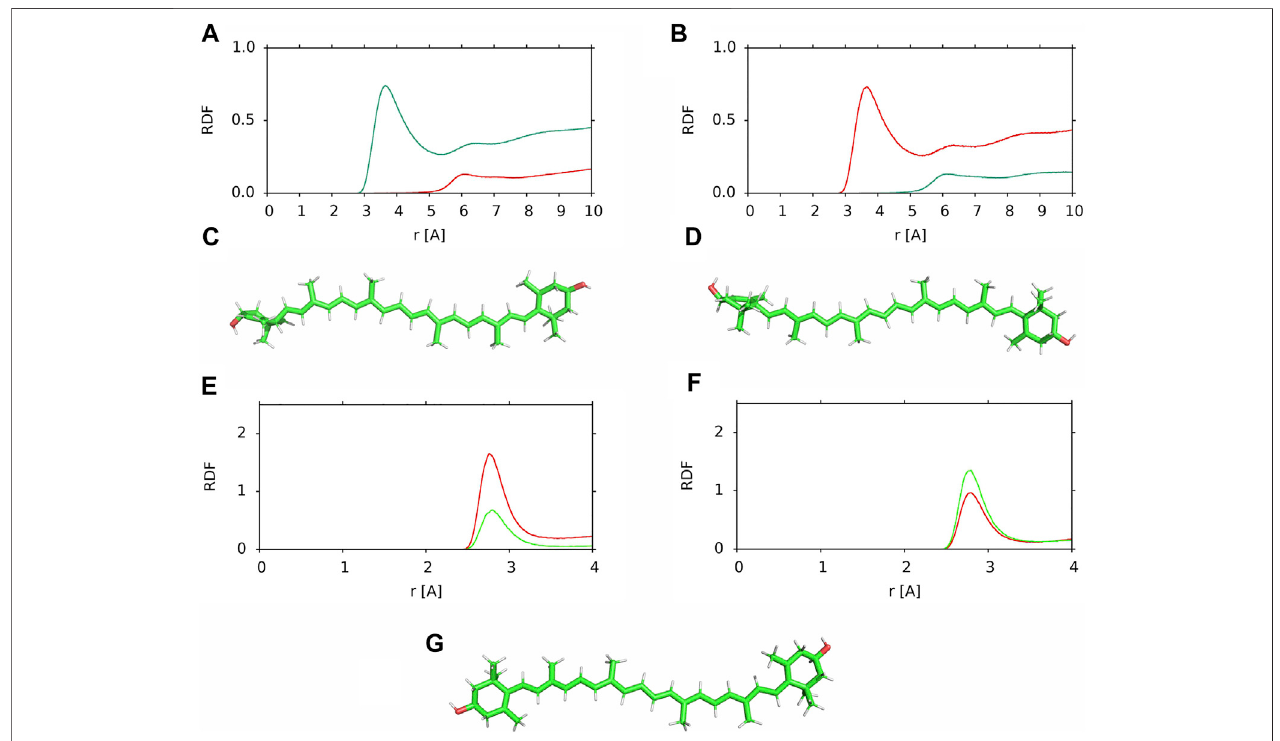
FIGURE 9 | (A,B) RDF of water molecules relative to the MET groups of the ( red ) ß -ring and ( green ) ε -ring halves of the polyene chain in the PC-LUT_H bilayer (A) lutein#6, (B) lutein#4; (C,D) positionsrelativetothe “ upper ” bilayerlea fl etofthehorizontallyorientedluteinmoleculesinthePC-LUT_Hbilayer (C) lutein#6, (D) lutein#4; (E,F) RDF of water molecules relative to the OH groups of the (E) ß -ring and (F) ε -ring in the PC-LUT_H bilayer ( red ) lutein #6 and ( green ) lutein #4; (G) position of zeaxanthin #1 in the horizontal position in the PC-ZEA_H bilayer. RDFs are cut at 10 or 4 Å.